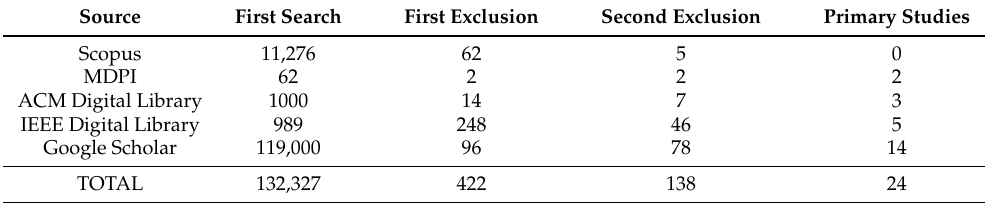
Table 2. Primary studies obtained according to the inclusion/exclusion criteria for each source.